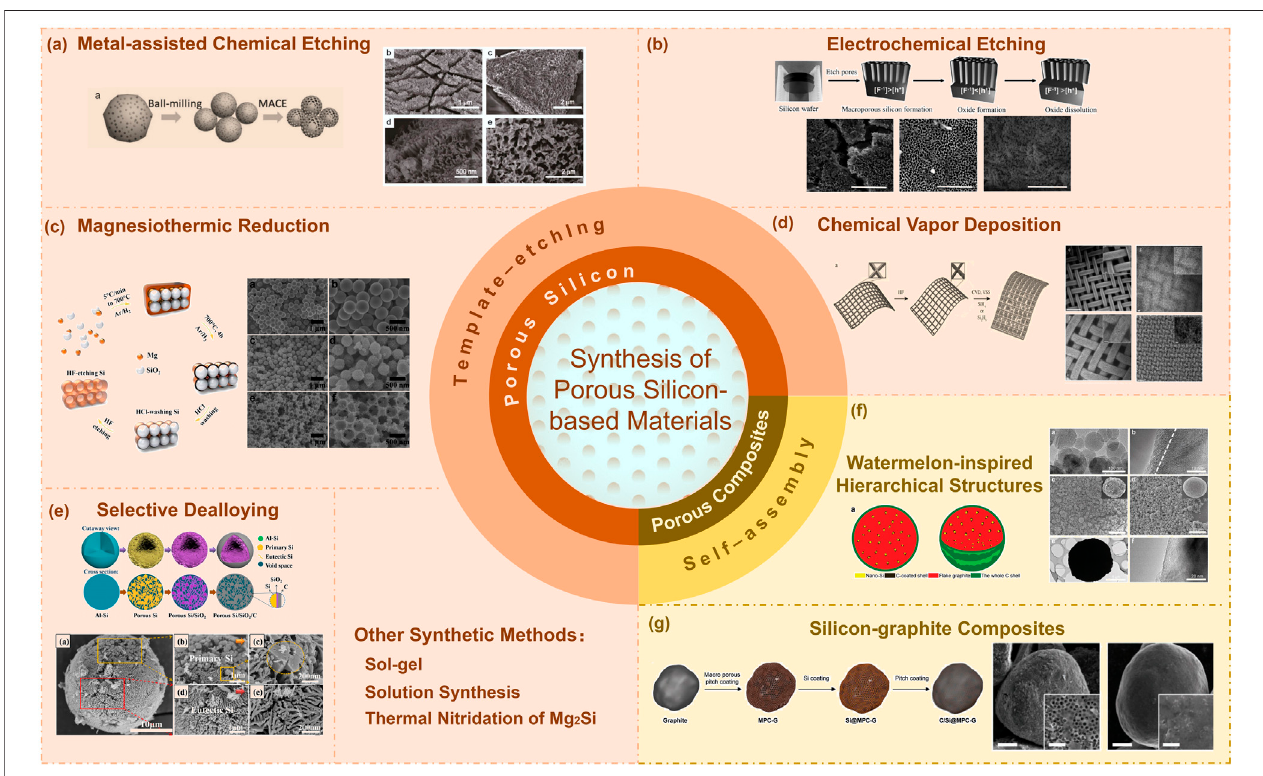
FIGURE 2 | The various synthetic routes and structural characteristics of different methods for porous silicon-based materials. The inserted graphics are adapted with permission from (Thakur et al., 2012; Jin et al., 2015; Xu et al., 2017; Zuo et al., 2017; Harpak et al., 2019; Wang et al., 2019; Son et al., 2020).